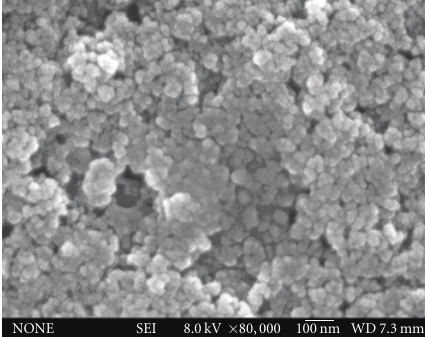
Figure 1: XRD patterns of photocatalysts calcined at 450 ◦ C. (200), (105) anatase crystal plane di ff raction, respectively. There were no apparent di ff raction peaks at 27.5 ◦ and 54.5 ◦